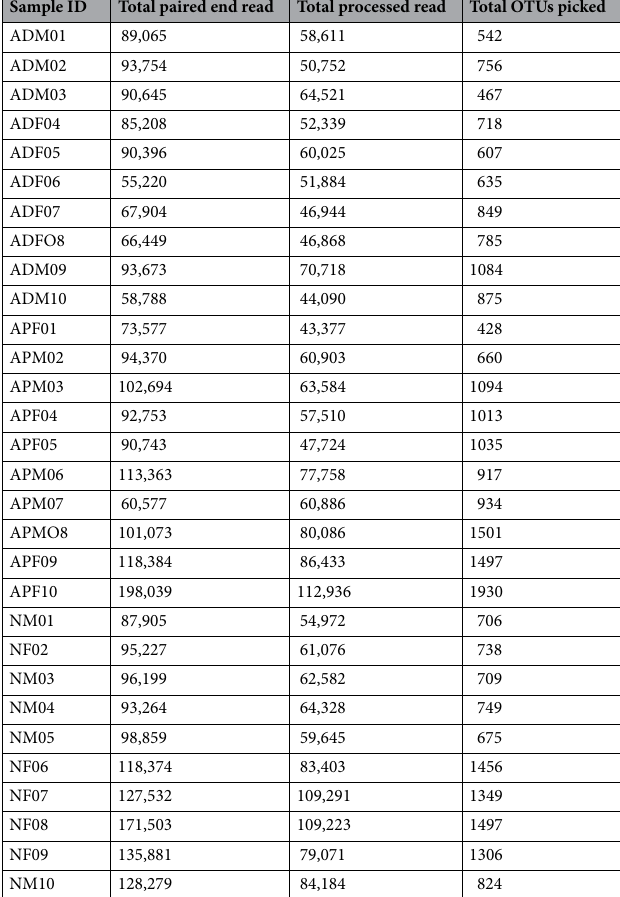
Table 1. Read count statistics for adi tribe, Apatani tribe and Nyshi tribe fecal samples of the V3–V4 region; Total OTUs picked—observed species in complete